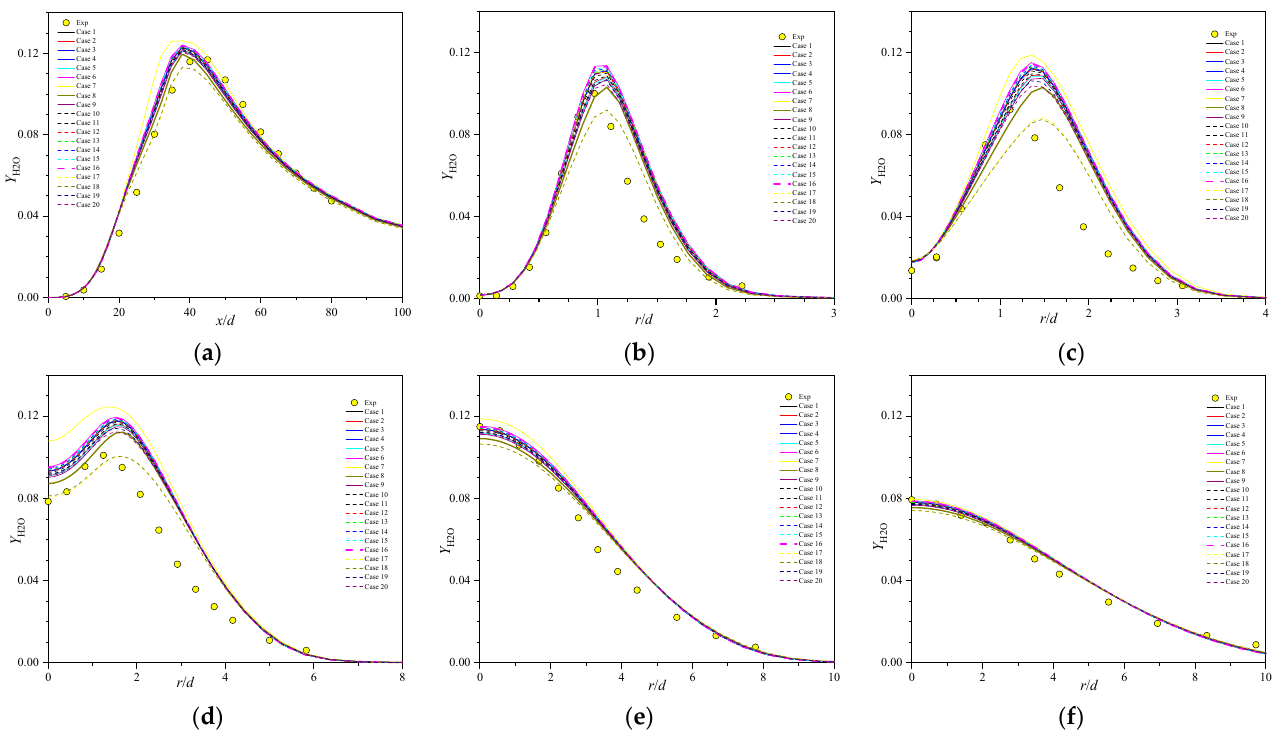
Figure 8. Comparison of measured [22,24] and predicted mean H 2 O mass fraction profiles for the Sandia Flame D with 20 combinations of the primary EDC constants C D1 and C D2 . ( a ) @axis. @ x / d = 7.5. ( c ) @ x / d = 15. ( d ) @ x / d = 30. ( e ) @ x / d = 45. ( f ) @ x / d = 60. The predicted peaks of the mean mass fractions of H 2 O are decreased with the mod- ified EDC constants and the largest is attributed to case 8, as expected. The results (at x / d = 15 and 30, Fig_S5 in [42]) from local modification of EDC constants for flame D show